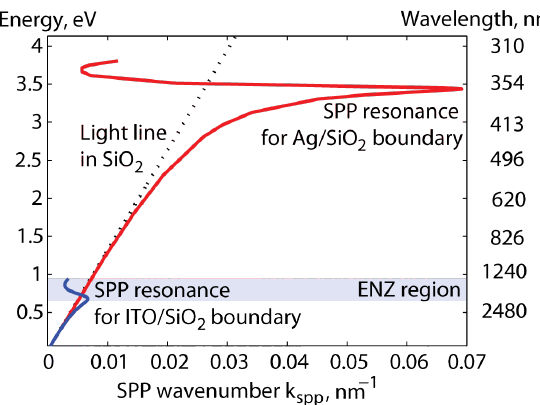
Figure 3: Dispersion of SPPs on silver/silica and ITO/silica inter- faces. For the case of silver, the SPP resonance is in the ultraviolet range and cannot be tuned (detailed analysis of resonant properties can be found in Refs. [99] and [100]). For the ITO film, the resonance is on the NIR wavelength and can be used for telecom applications.